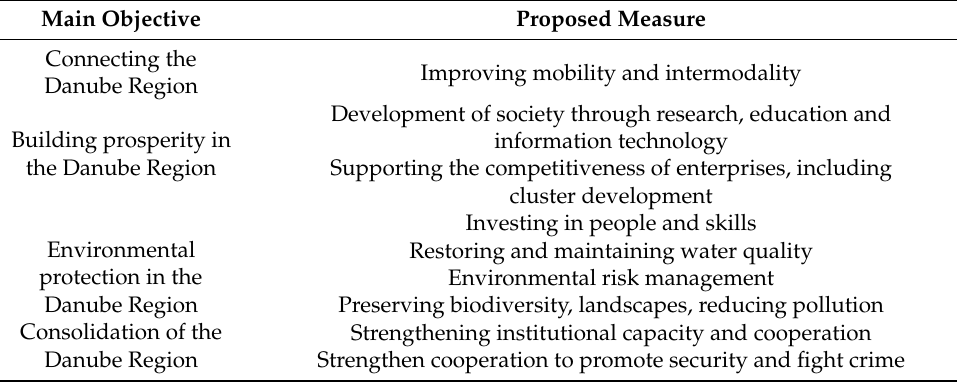
Table 3. Technical measures taken by the European Commission to streamline freight traffic on the Danube. Main Objective Proposed Measure Connecting the Improving mobility and intermodality Danube Region Development of society through research, education and Building prosperity in information technology the Danube Region Supporting the competitiveness of enterprises, including cluster development Investing in people and skills Environmental Restoring and maintaining water quality protection in the Environmental risk management Danube Region Preserving biodiversity, landscapes, reducing pollution Consolidation of the Strengthening institutional capacity and cooperation Danube Region Strengthen cooperation to promote security and fight crime Source: European Union Strategy for the Danube